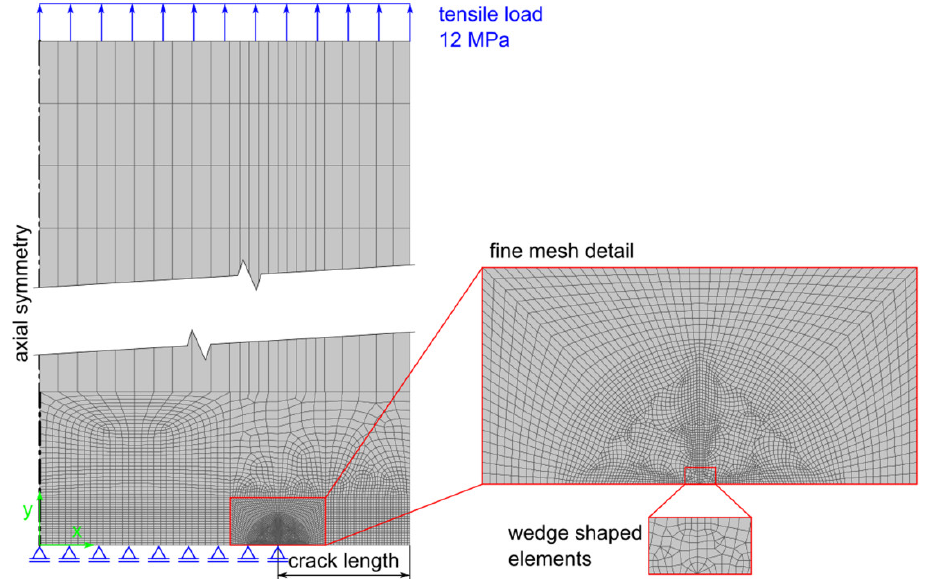
Figure 2. Mesh of the model used for the FEM calculation of the J-integral for CRB specimens.